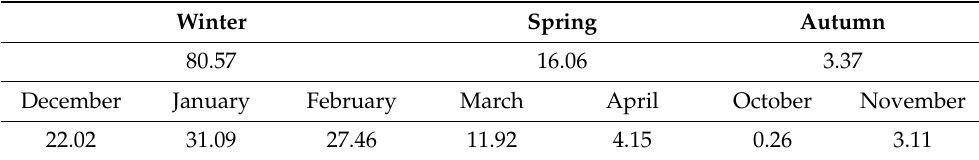
Table 1. Percentage distribution of snow days in Madrid, 1920–2020.